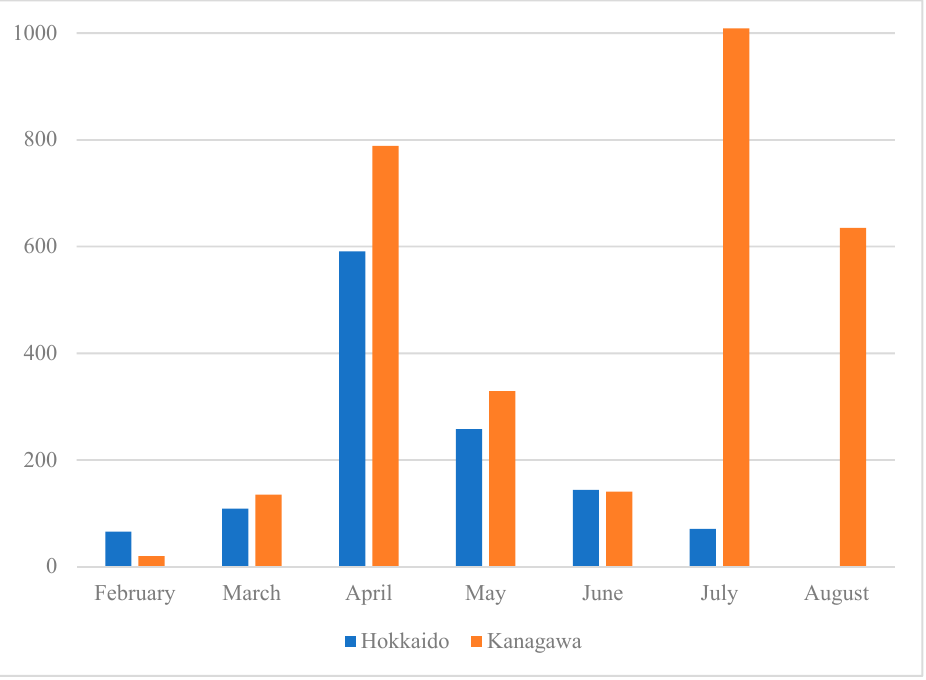
Figure 1. Number of Confirmed COVID-19 Cases by prefectures. The number of COVID-19 cases in Hokkaido and Kanagawa from February 2020 to August 2020. Hokkaido numbers are in blue, and Kanagawa numbers are in orange. Hokkaido’s COVID-19 case numbers peaked in April, corresponding to the first peak of the disease in Kanagawa. There was a second, higher peak in the number of COVID-19 cases in Kanagawa in